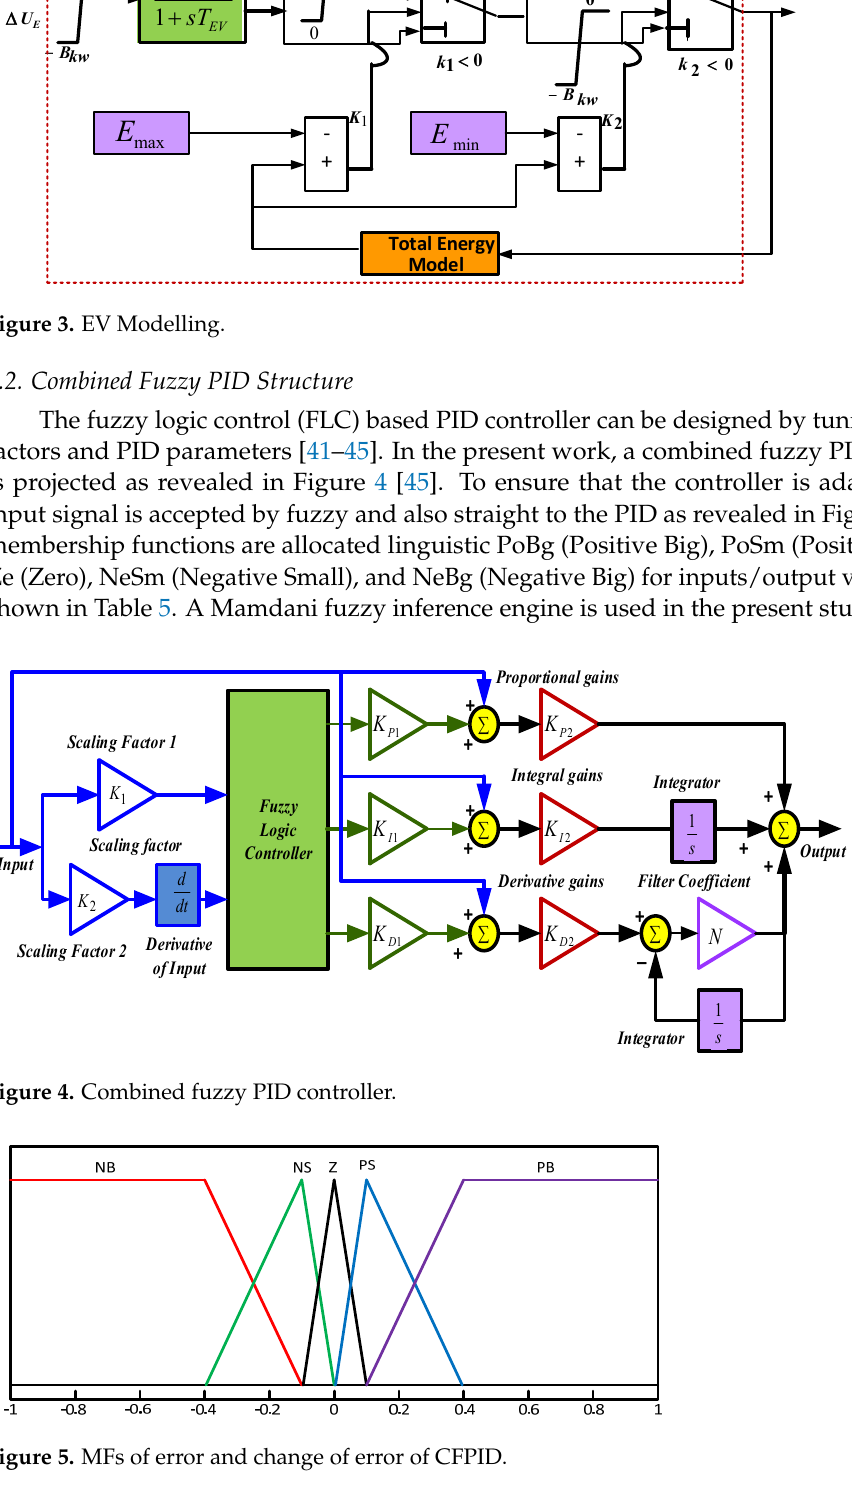
Figure 3. EV Modelling.